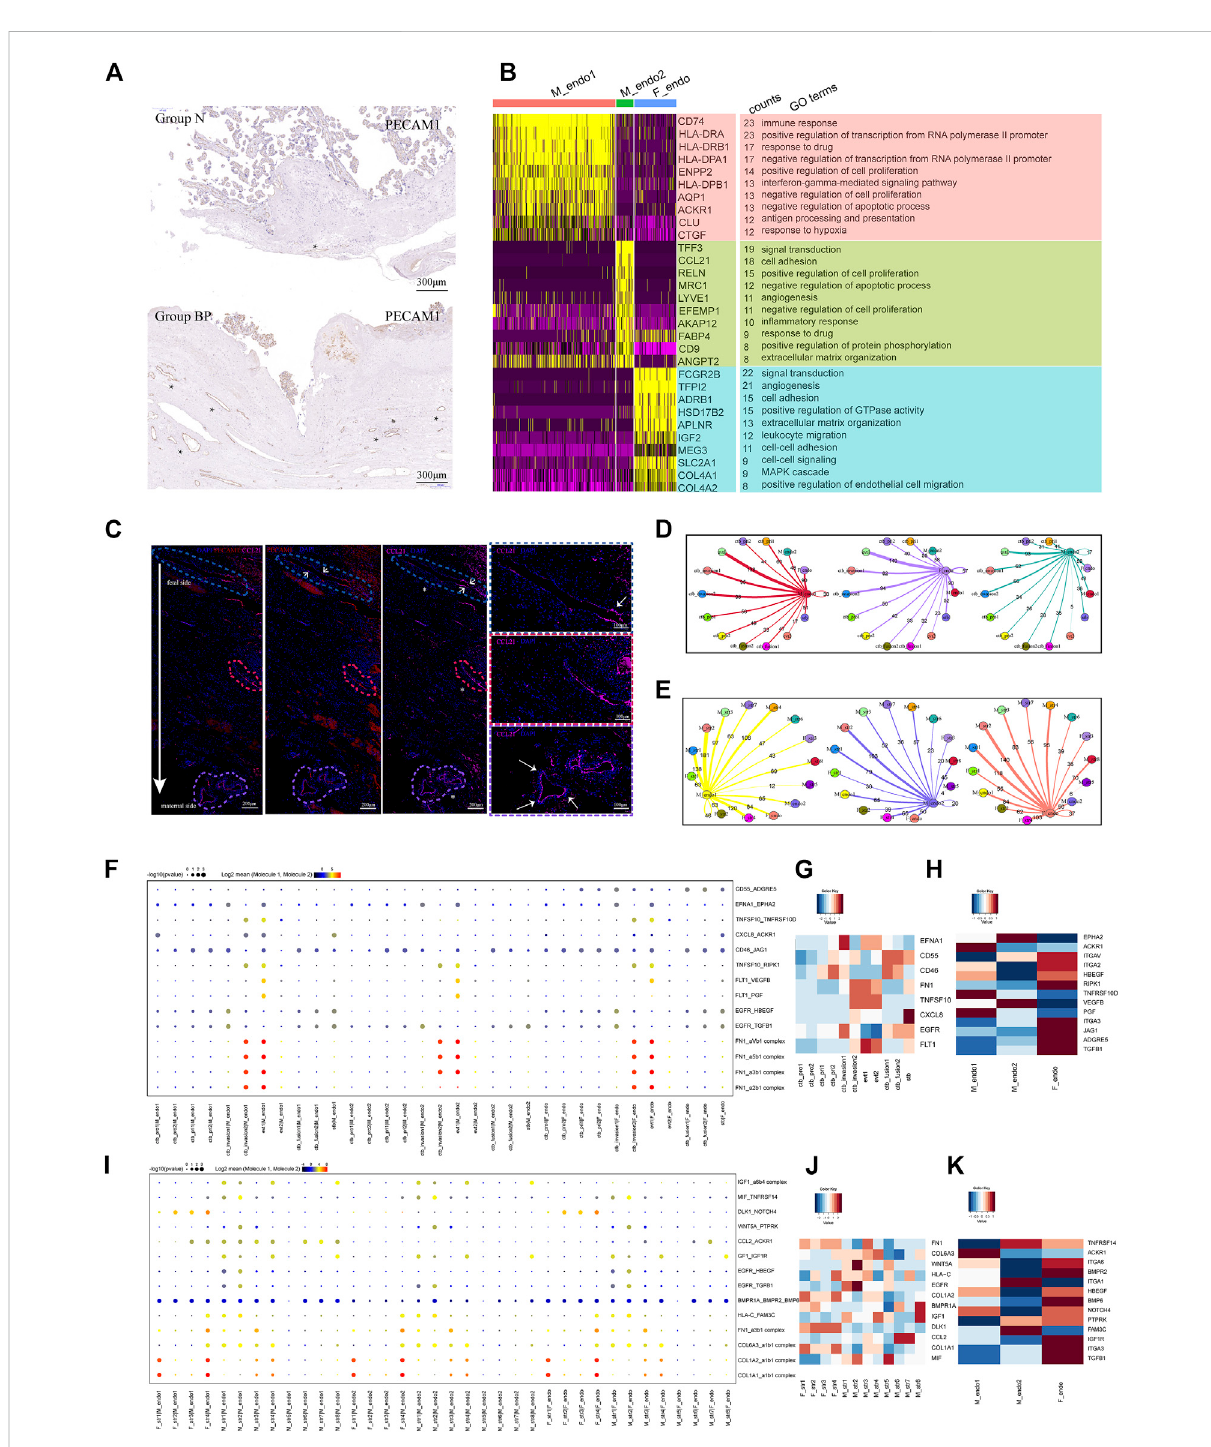
FIGURE 4 Enhanced differentiation of CTB into EVT might lead to increased angiogenesis in PAS placenta. (A) IHC with tissue from groups N and BP showing increased vasculature formation in the BP group. (B) GO analysis revealed the difference between the two types of maternal endothelial cells as well as fetal endothelial cells. (C) IF with tissue from the BP group showing the distribution of maternal endothelial cells. From the fetal to maternal side, the vessel was gradually dominated by CCL2 + endothelial cells. * blood vessels. (D) Statistical analysis of the number of ligand ‒ receptorpairsbetweenendothelialcellsandtrophoblasts. (E) Statisticalanalysisofthenumberofligand ‒ receptorpairsbetweentheendothelialcells and stromal clusters. (F) CellPhoneDB analysis showing the ligand ‒ receptor pairs among trophoblasts and vessel endothelial cells (G) . (H) The averageexpressionlevelsofinteractingmoleculesbetweentrophoblastsandendothelialcells. (I) CellPhoneDBanalysisshowingtheligand ‒ receptor pairs among stromal cells and endothelial cells (J) . (K) The average expression levels of interacting molecules between stromal cells and endothelial